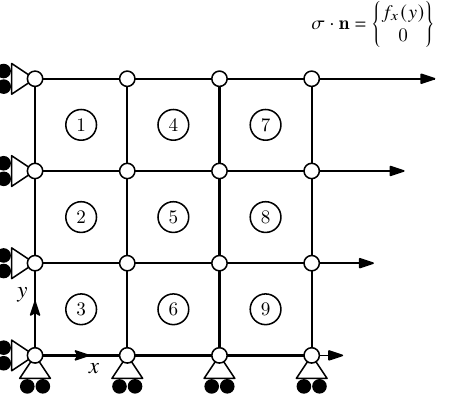
Figure 20. Heterogeneous test: initial geometry, mesh and boundary